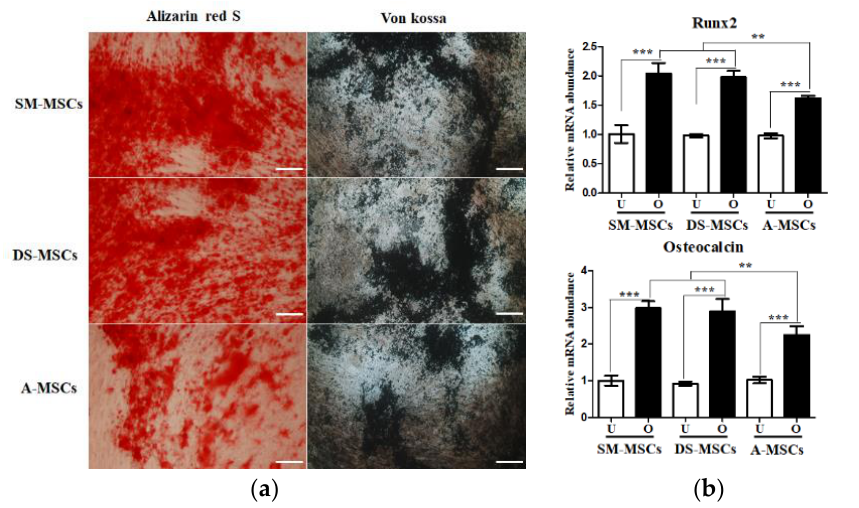
Figure 5. The results of in vitro osteoblast differentiation of MSCs derived from skeletal muscle (SM-MSCs), dermal skin (DS-MSCs), and adipose tissue (A-MSCs). ( a ). Cytochemical staining of differentiated osteoblasts. Scale bar = 200 µm. ( b ). Results of RT-qPCR for osteoblast-specific markers in differentiated cells. All osteoblast-specific markers were significantly higher in differentiated osteoblast from SM-MSCs and DS-MSCs than that from A-MSCs. Data are represented by the mean ± SD of four independent experiments. Asterisks indicate significant difference between the undifferentiated cells and differentiated cells (** p < 0.01; *** p < 0.001). White bar: undifferentiated cells; black bar: differentiated cells; U: undifferentiated cells; O: osteogenic differentiated cells.